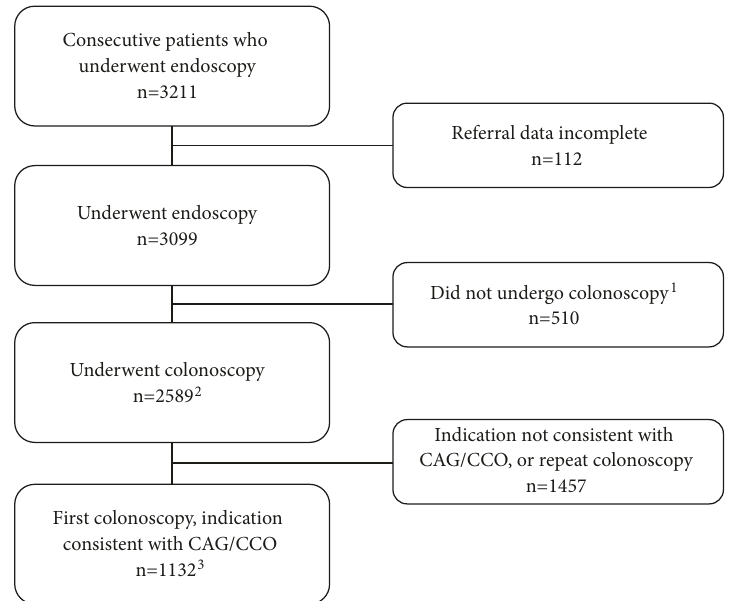
Figure 1: Patient selection. CAG: Canadian Association of Gastroenterologists, CCO: Cancer Care Ontario, 1 patients underwent an endoscopic procedure other than a colonoscopy, 2 patients included in secondary analysis (quality indicators and complication rates), and 3 patients included in primary analysis (wait